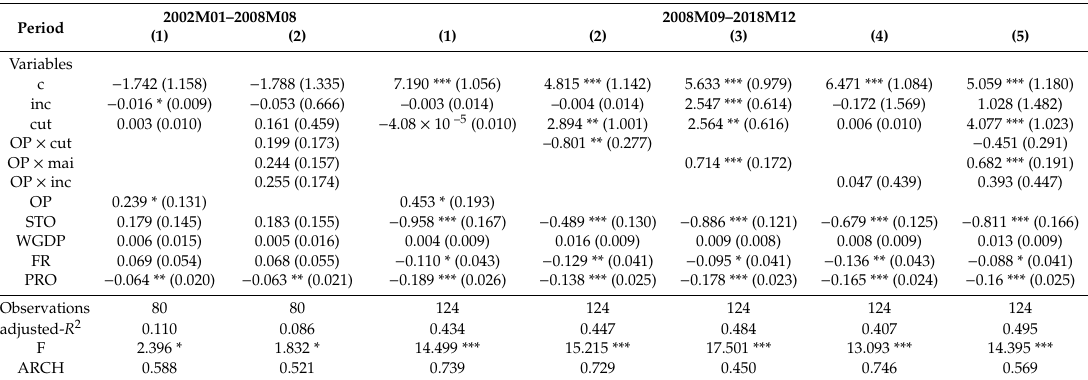
Table 4. Estimation results during pre- and post-crisis